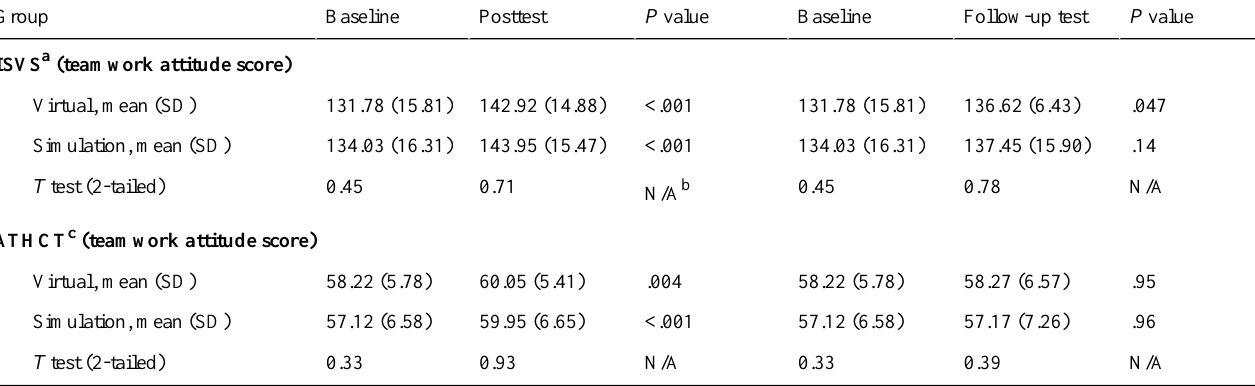
Table 3. Comparison of teamwork attitude scores on Interprofessional Socialization and Valuing Scale and Attitudes Toward Interprofessional Health Care